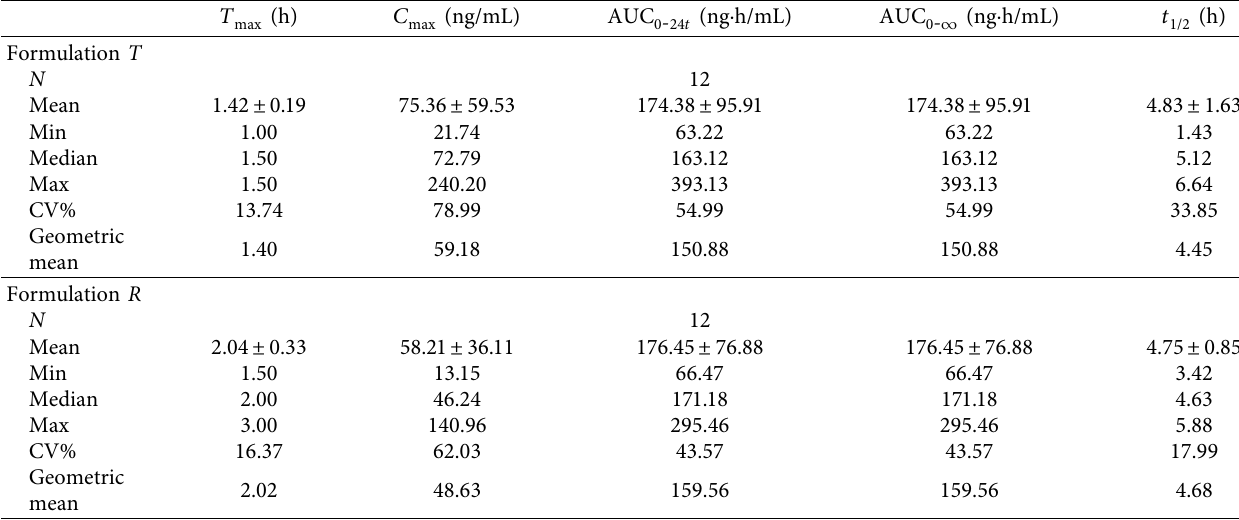
Figure 4: Chromatogram for plasma concentration of 35ng/mL that diluted within the calibration range. Table 7: Pharmacokinetic parameters of the optimized formulation of vardenafil orodispersible tablet (test) and marketed orodispersible tablet formulation (reference) in New Zealand white